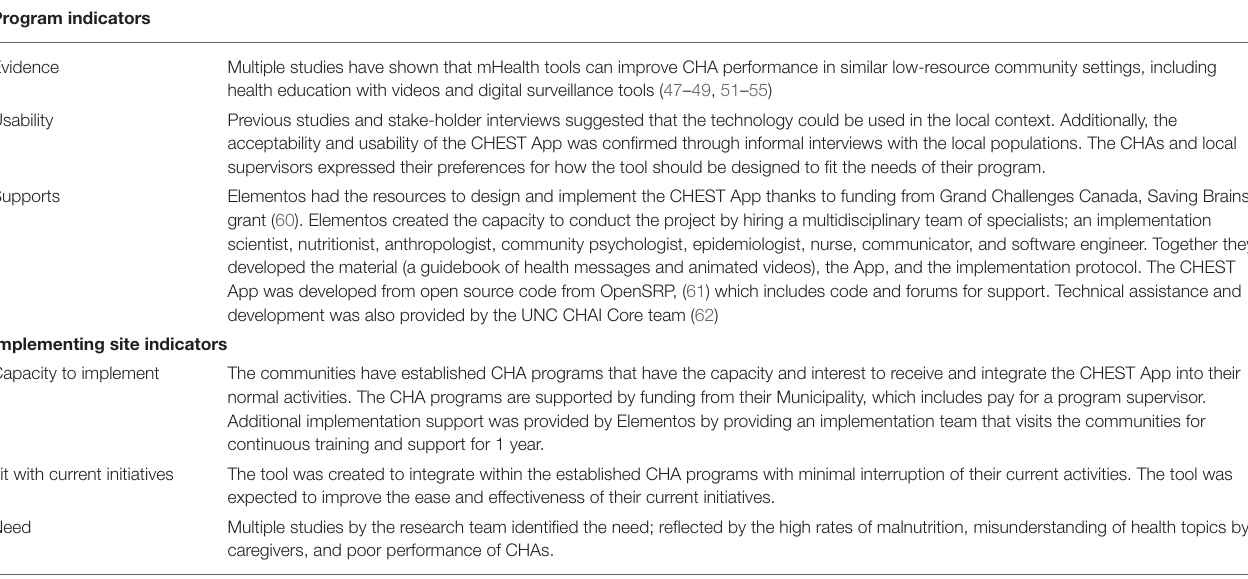
TABLE 2 | The hexagon exploration tool assessment of the CHEST